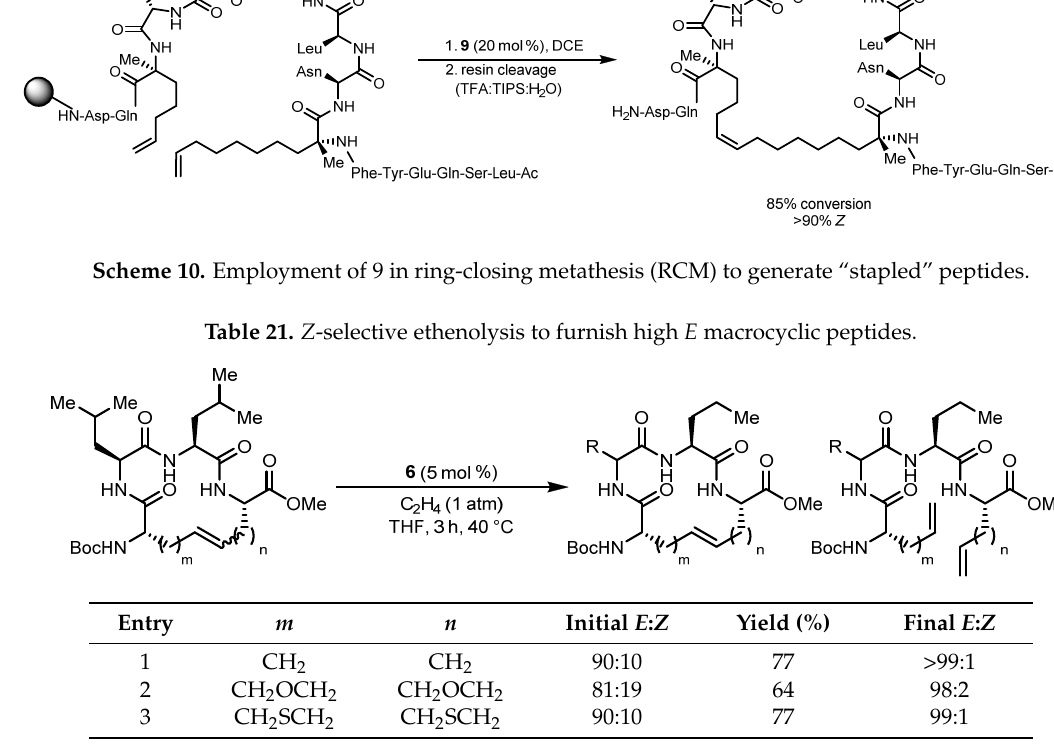
Table 22. Anti -diols synthesized through tandem catalysis.